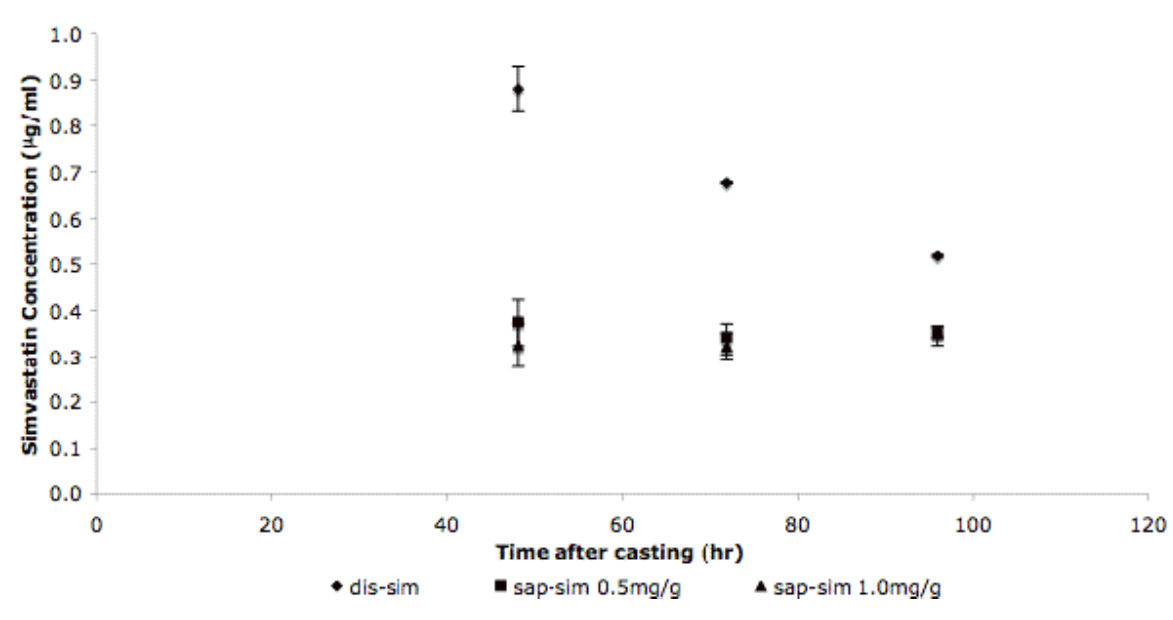
Figure 3. Simvastatin net release-profiles. Samples of membrane were dried and the simvastatin extracted then quantified by HPLC, and relative concentrations calculated from a calibration curve (not shown); n =